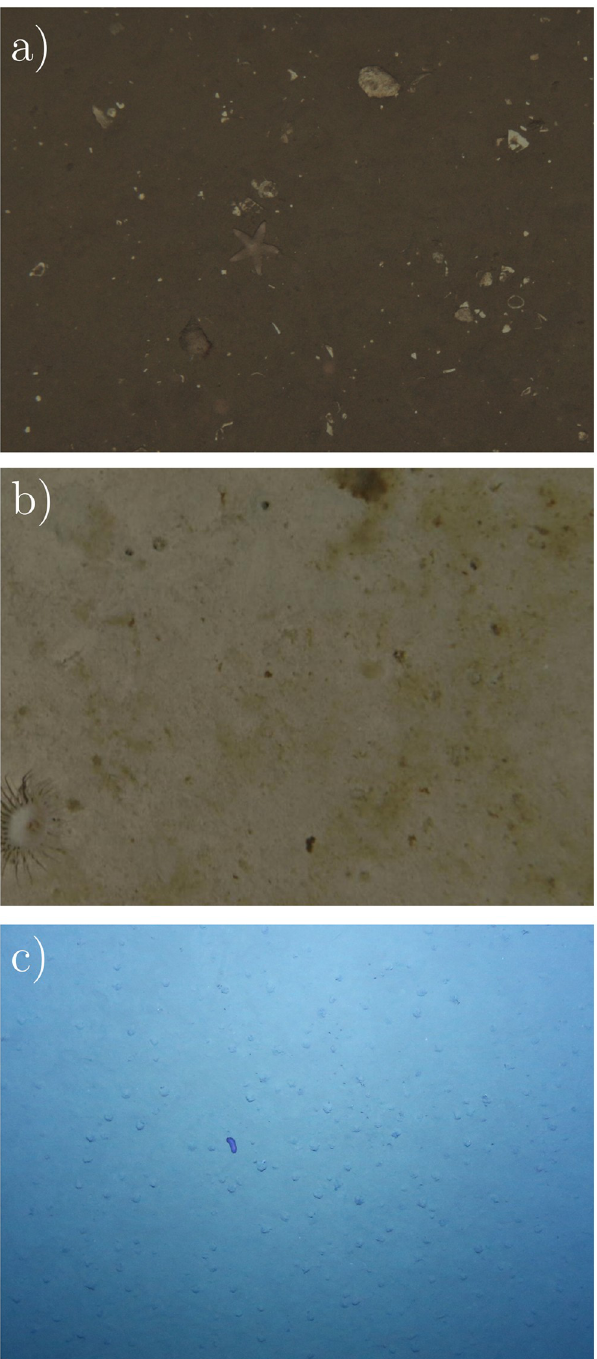
Fig 5. Crops of example images of the JC77 (a), PAP (b) and SO242 (c) datasets. Note the rocks and scattered shell fragments that are no OOI in JC77 (a) and the irregular illumination in SO242 (c).